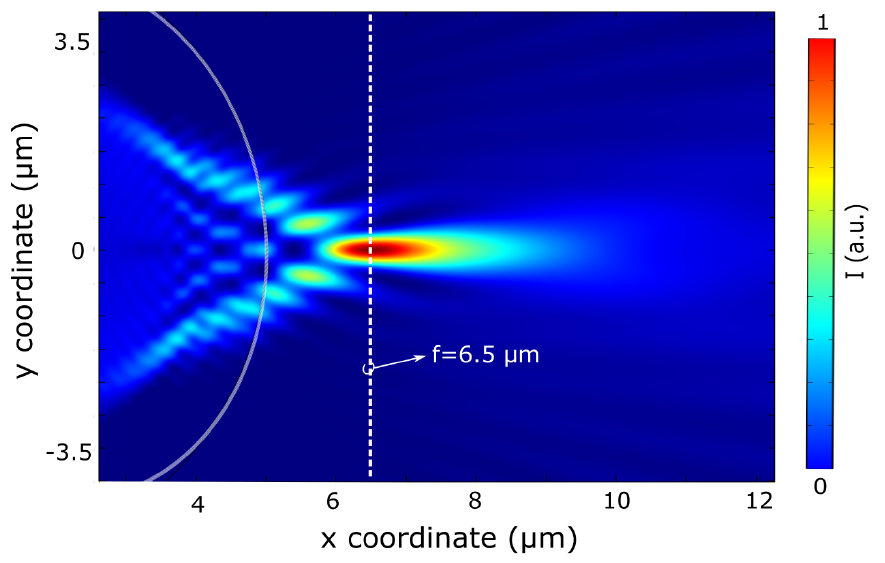
Figure 6. Calculated intensity of PNJ creation via a 10 µ m diameter silica microcylinder illuminated by a 637 nm continuous plane wave in the x